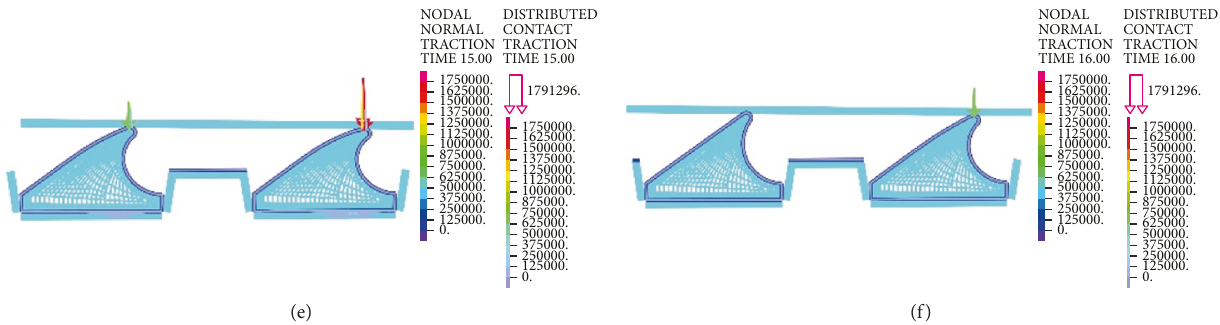
Figure 21: Contact stress distribution of the rubber rings before optimizing during anticlockwise rotation. (a) Deflection 0.2 ° . (b) Deflection 0.4 ° . (c) Deflection 0.6 ° . (d) Deflection 0.8 ° . (e) Deflection 1.0 ° . (f) Deflection 1.2 ° .